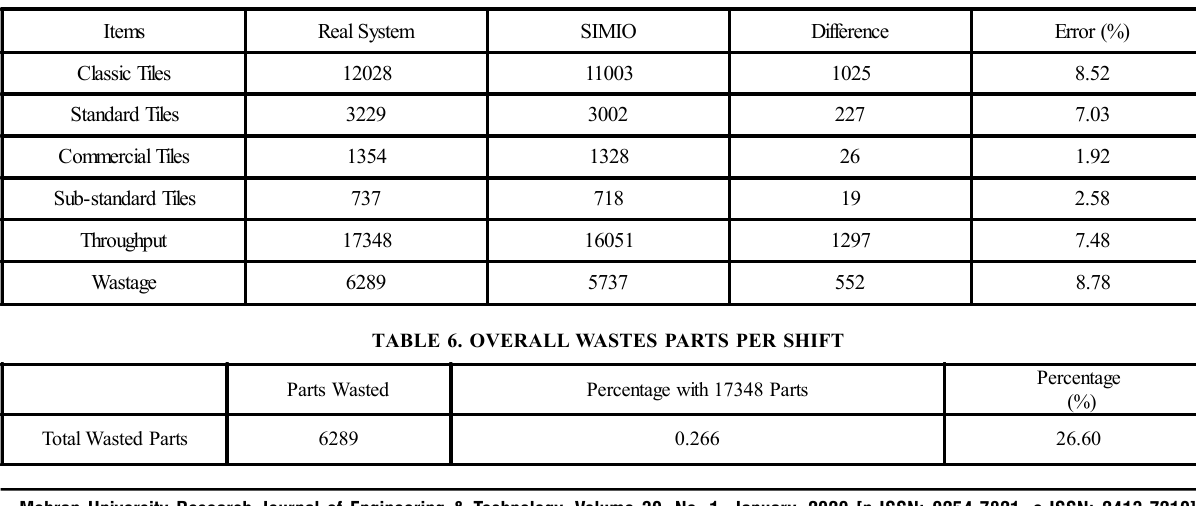
FIG. 6. RESULTS OF THE THROUGHPUT OF FOUR TYPES OF TILES IN SIMIO SOFTWARE TABLE 5. VALIDATION- FIND DIFFERENCES BY COMPARING THE RESULTS OF REAL SYSTEM AND SIMULATIONS